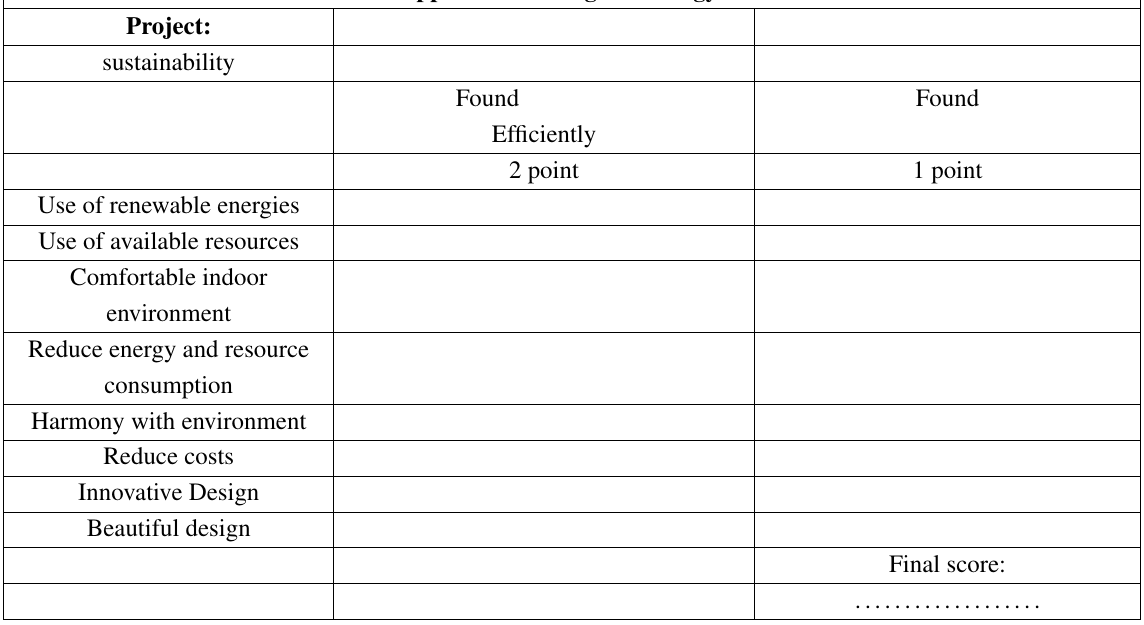
Table 1. Proposal Checklist to